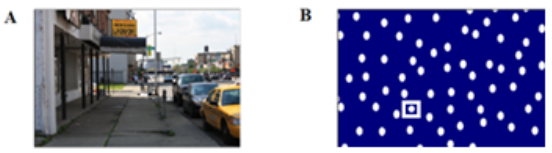
Figure 1. An urban scene used in a scene viewing task, and a sample display with a target circle among ovals, used in visual search tasks included in the new eye movement data for the meta-analysis. The square in the visual search display depicts for the reader, the position of the target in this particular dis-